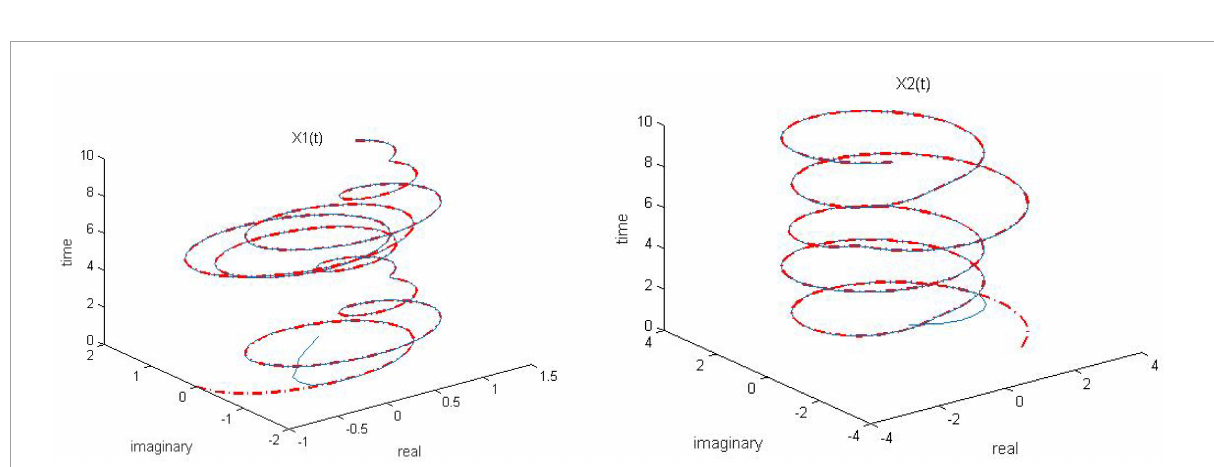
FIGURE7 Dynamic complex matrix equation (DCME) (1) solved by robust zeroing neural network (RZNN) model (11) with k = 1 in n(t) = 0.5 polluted environment.